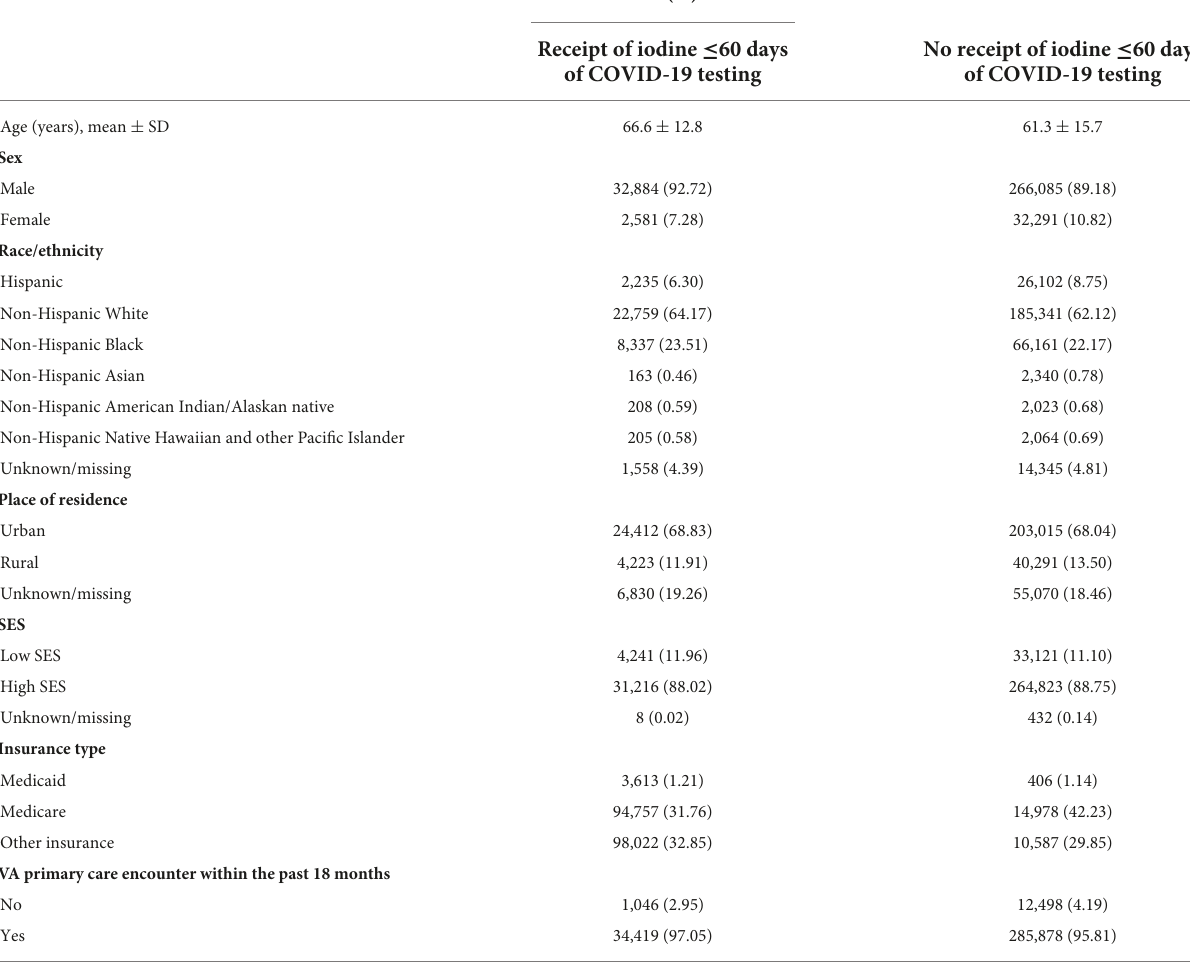
TABLE 1 Descriptive characteristics of the study cohort ( n = 333,841